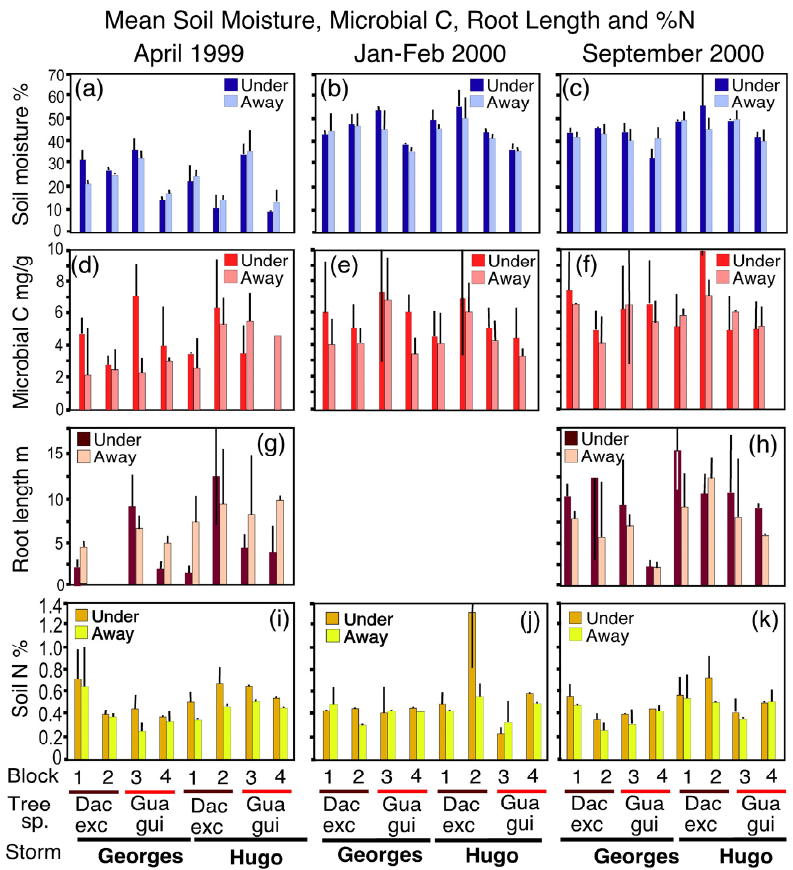
Figure 4. Mean % soil moisture, microbial biomass C, total root length and soil % N are presented for paired (8 × 8 cm) soil cores taken to 10 cm depth under decomposing logs (darker bars) versus samples taken 20–50 cm away and not under the logs (lighter bars). April 1999 sampling was during the dry season, 0.6 and 9.5 years after Hurricane Georges and Hugo, respectively. January 2000 was the end of the wet season, 1.4 and 10.4 years after Hurricanes Georges and Hugo, respectively. September 2000 was during the wet season 2 and 11 years after Hurricanes Georges and Hugo, respectively. Data are means of two samples, one taken in the upslope direction and the other taken in the downslope direction on the same day (SD bars in black). Tree species abbreviations are: Dac exc— Dacryodes excelsa , and Gua gui— Guarea guidonia . One log from each hurricane (Georges 1998) and Hugo (1989) is within each of the four blocks. ( a – c ): Mean % soil moisture; ( d – f ): Mean microbial biomass C; ( g , h ): Mean m root length; ( i – k ): Mean soil % N.